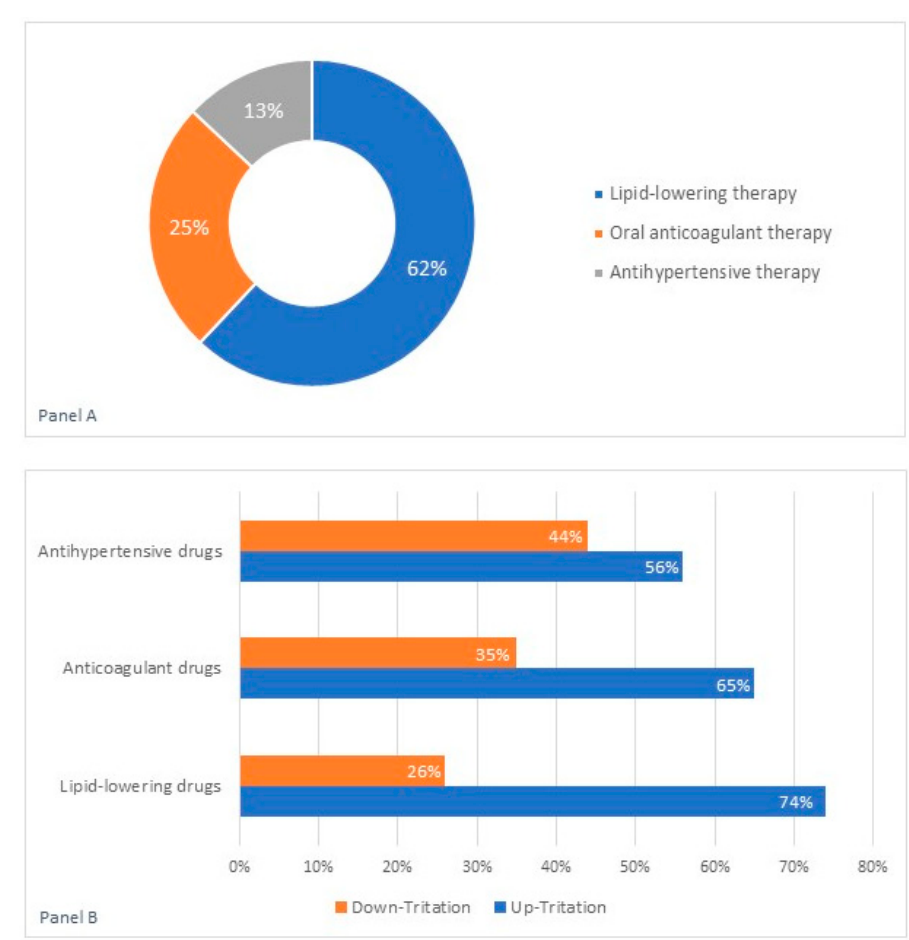
Figure 2. Type of therapy (Panel A) and dose adjustment (Panel B) following the nursing teleconsultation.